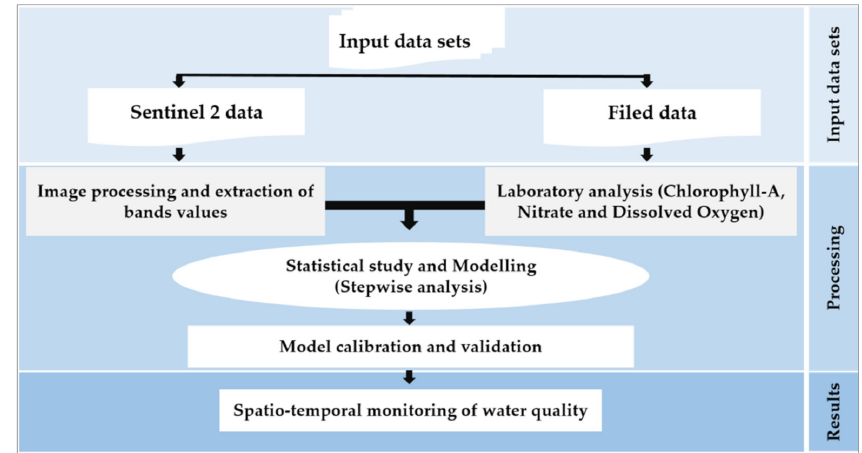
Figure 4. Flowchart of the methodology